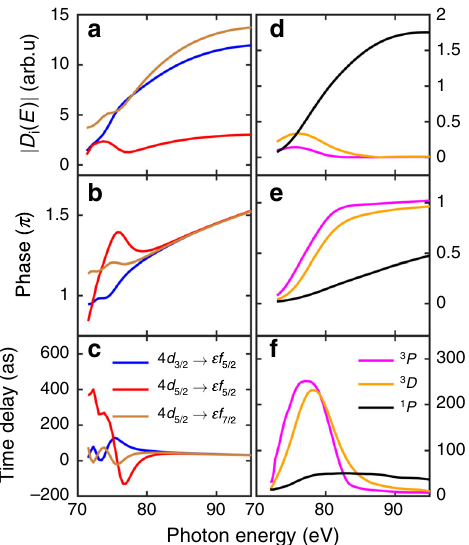
Fig. 4 Transition matrix elements. a , d Modulus, b , e phase and c , f time delay of the transition matrix element D i ( E ) as a function of photon energy for the coupled channels ( a – c ) 4 d 3/2 → ϵ f 5/2 (blue), 4 d 5/2 → ϵ f 5/2 (red), 4 d 5/2 → ϵ f 7/2 (brown) and eigenchannels ( d – f ) 1 P (black), 3 P (magenta), 3 D (orange), extracted from ref. 12 . We exclude the Coulomb phase-shift in b , e and c , f . A π phase shift has been added to the phase of 4 d 5/2 → ϵ f 5/2 for better comparison. The time delay is the energy derivative of the